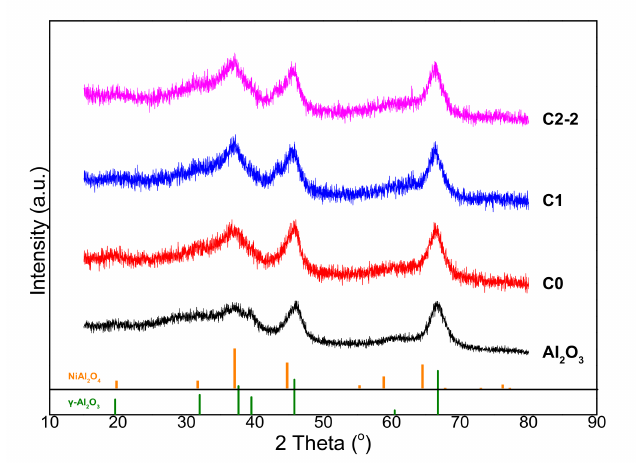
Figure 1. The XRD patterns of Al 2 O 3 and M-Ni / Al 2 O 3 samples, (C0) 10Ni / Al 2 O 3 , (C1) 10Ni4Cu / Al 2 O 3 , and (C2-2) 10Ni4Zn / Al 2 O 3 .